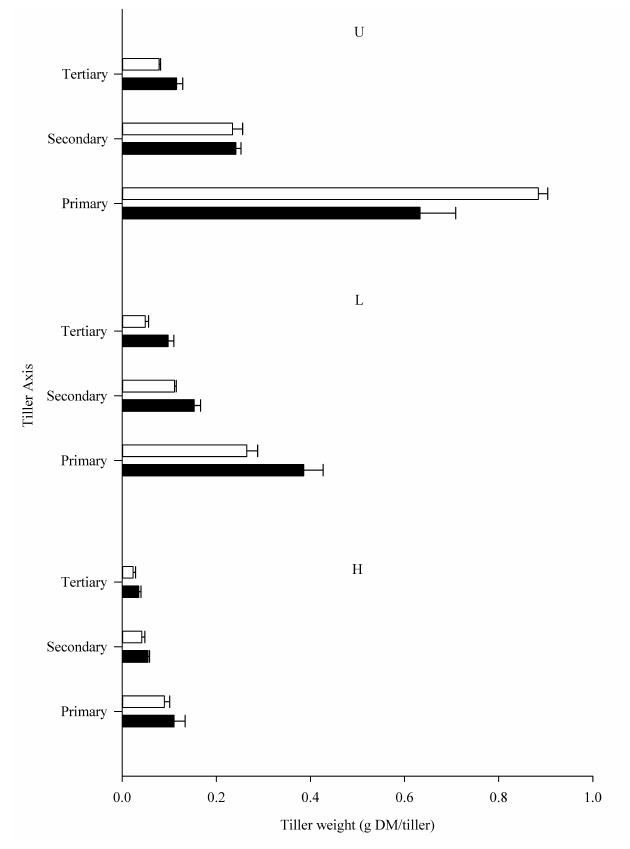
Figure 1. Mean ± SE for tiller weights at the primary, secondary and tertiary tiller axes of non-rhizomatous ( ■ ) and rhizomatous ( □ ) tall fescue populations when plants were undefoliated (U), or received lax (L) defoliation to 100 mm stubble, or hard (H), defoliation to 50 mm stubble every three weeks for 18